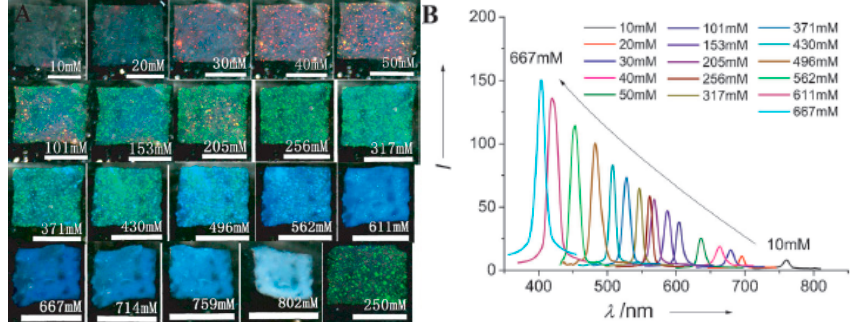
Figure 7. ( A ) Photographs of a freestanding PMCC film taken with [NaCl] increasing from 0 to 750 mM. The last one (bottom right) was taken when [NaCl] was decreased back to 250 mM. Scale bar: 0.5 cm. pH 3.0. T = 238 °C. ( B ) Reflection spectra of the PMCC film measured at various [NaCl] values. Reproduced with permission from [30].